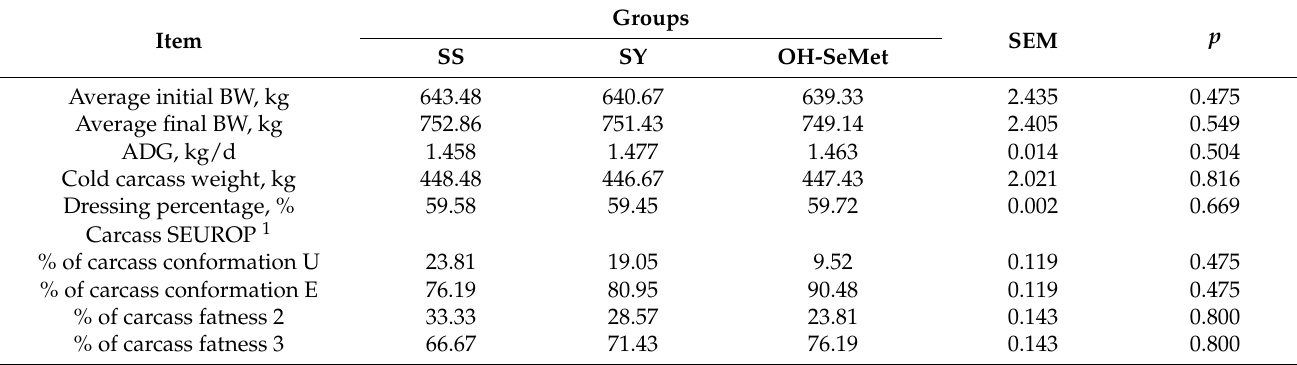
Table 2. The effect of the selenium source during the finishing phase on the growth performance and carcass